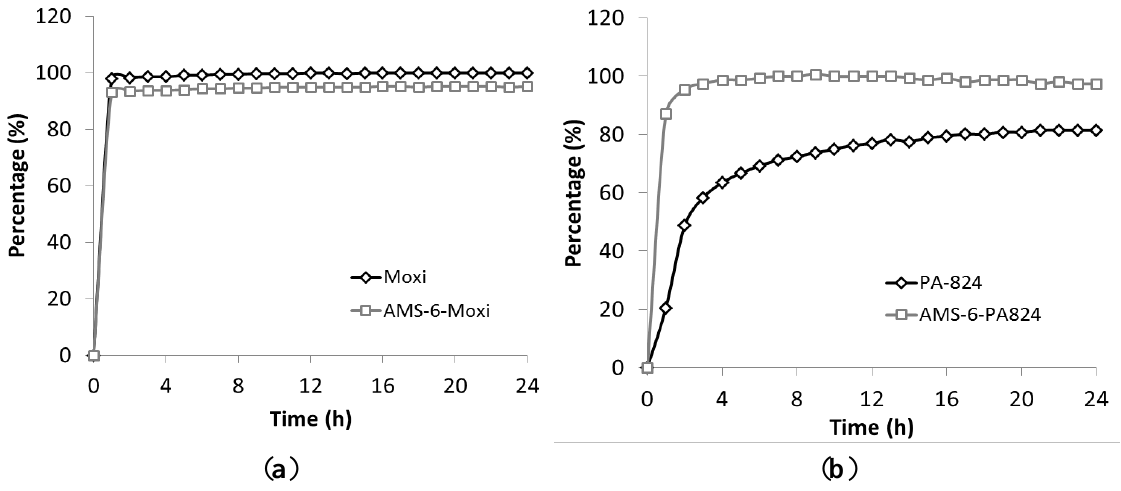
Figure 3. Kinetic release curves of ( a ) free and encapsulated moxifloxacin and